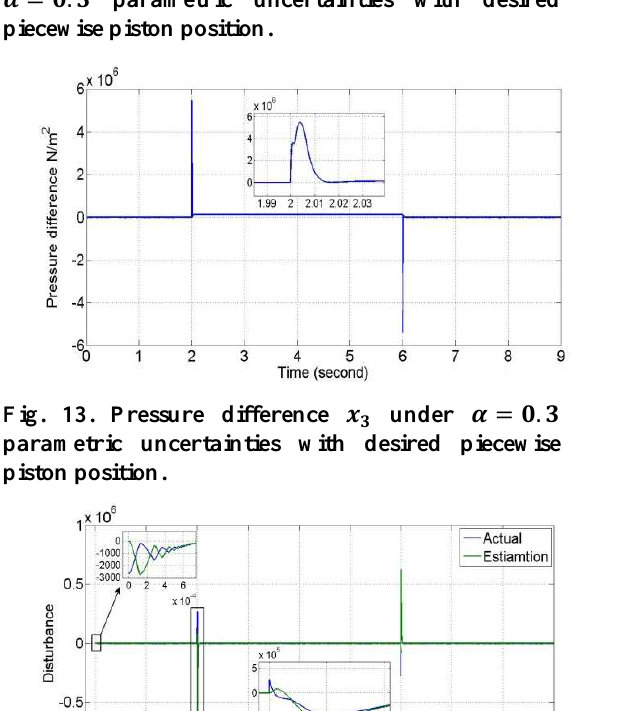
(cid:159) = (cid:160). £